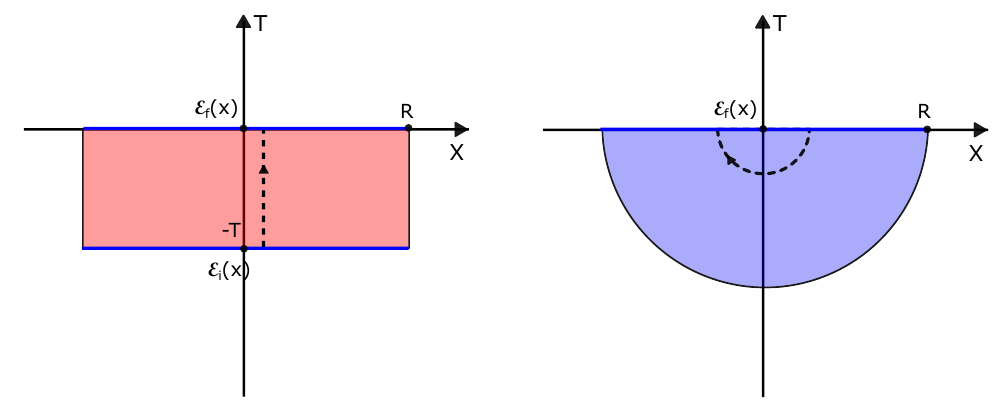
Figure 4 . Cutting open a path integral along a curve, requires summing over the intermediate value of E . In formulas: Z = R d E e (cid:0) A 1 E gives Z ( E ) (cid:24) e (cid:0) A 1 2 E 2 .